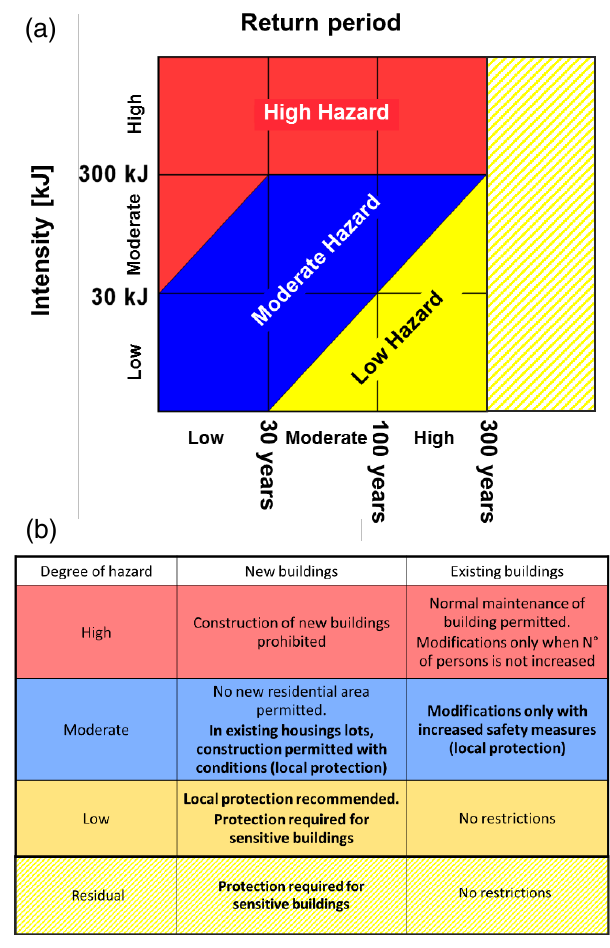
Figure 1. Swiss guidelines for rockfall hazard Fig 1. Swiss guidelines for rock fall hazard management. Above: intensity-frequency diagram for defining rock fall hazards (Raetzo 5 et al., 2002). Below: constraints to new and existing buildings/urban areas for regulating land use.